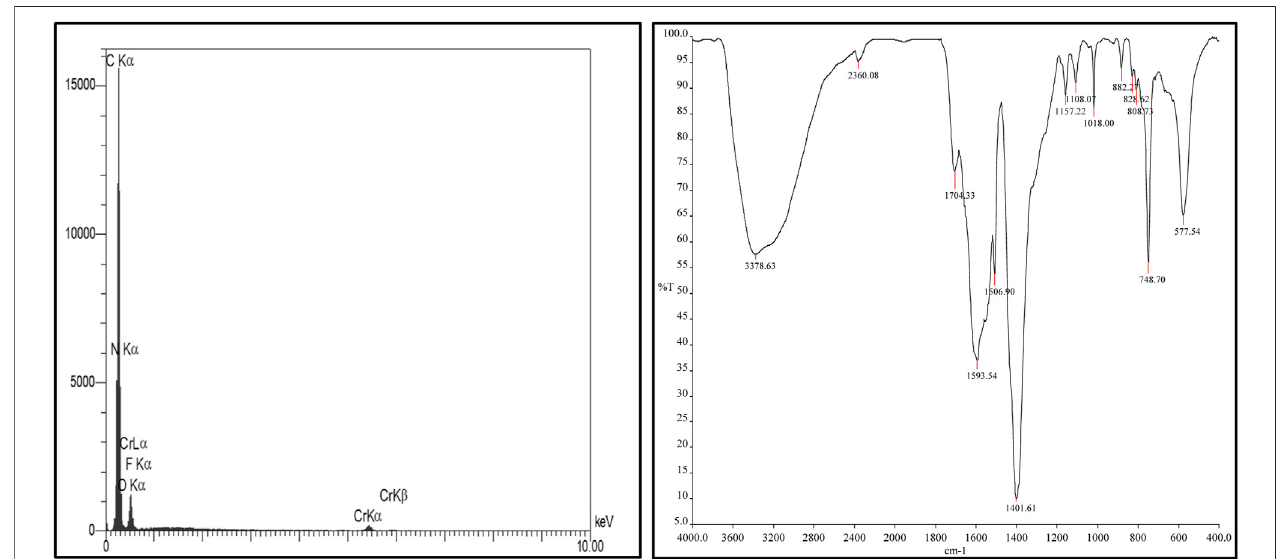
FIGURE 1 | EDX analysis and the FT-IR spectrum of the MIL-101(Cr) nanocatalyst.